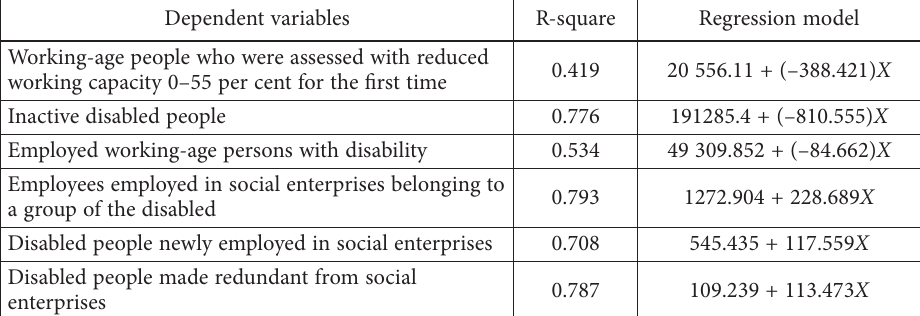
Table 2. Models of regression equation for social indicators (source: created by